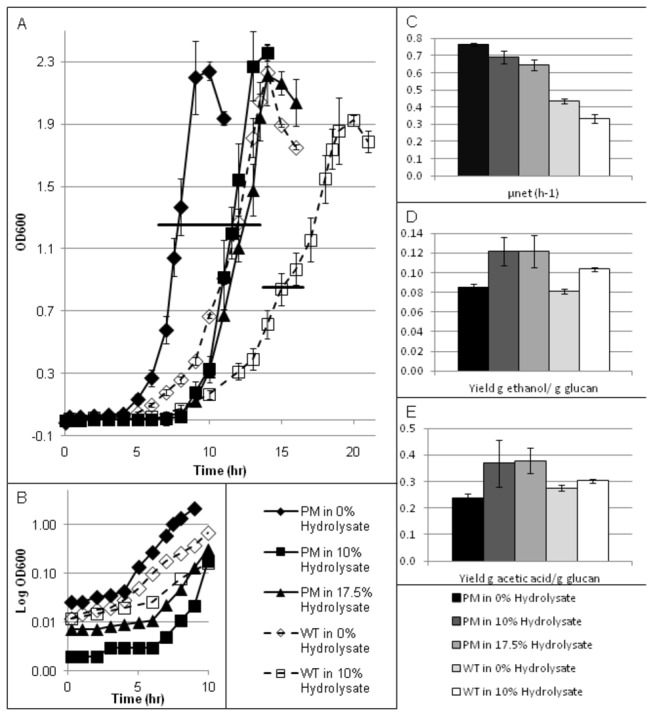
Growth comparison for WT and PM in various concentrations of Populus hydrolysate.(A) Optical density versus time. The horizontal bars indicate sample point for RNA-seq analysis, (B) the average OD on a log scale for the initial stages to emphasize the initiation of exponential growth, (C) net growth rate (ln(biomass/time, μnet), (D) yield of ethanol produced (g/L)/glucan utilized (g/L), and (E) Yield of acetic acid produced (g/L)/ glucan utilized (g/L).